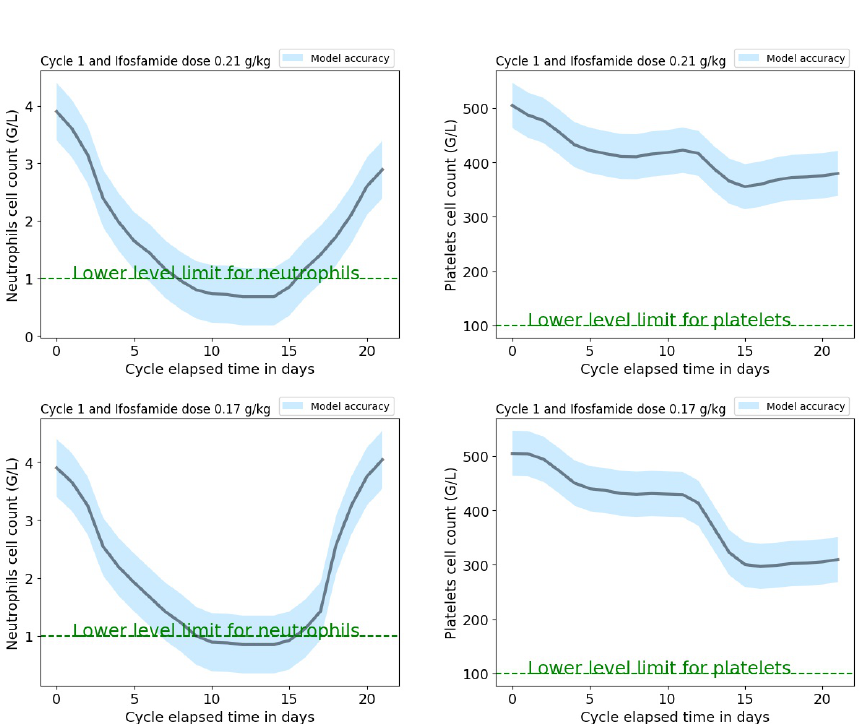
Figure 4. Example of a result obtained while using the web-based application. It shows the predicted neutrophils and platelets dynamic profiles for the first IVA treatment cycle for a new patient with initial neutrophils and platelets levels at 3.9 and 505 G / L and an ifosfamide weight-normalized dose set to 0.21 g / kg (upper plots) and 0.17 g / kg (lower plots). The blue bands illustrate the neutrophils and platelets model’s mean errors obtained from the validation procedure applied to the selected treatment cycle (Table 5). Green dashed lines show neutrophils and platelets lower limits for mild neutropenia and